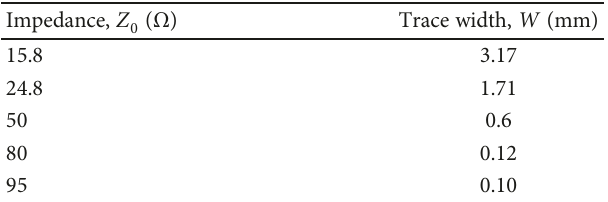
Figure 14: Telecom tile PCB layout; top 2 layers. Table 3: Computed trace widths with AWR Tx-line tool for RF front-end